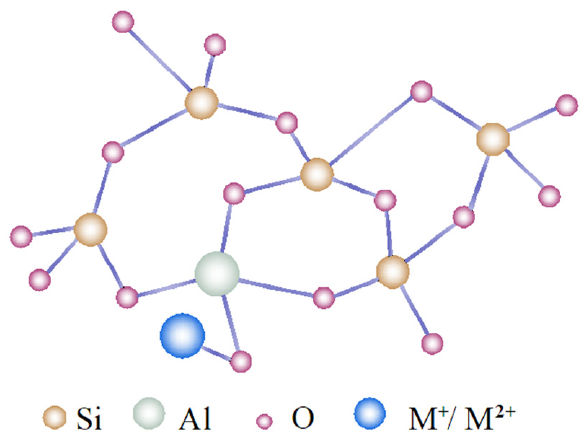
Figure 13. Schematic diagram of CNS glassy phase spatial structure.